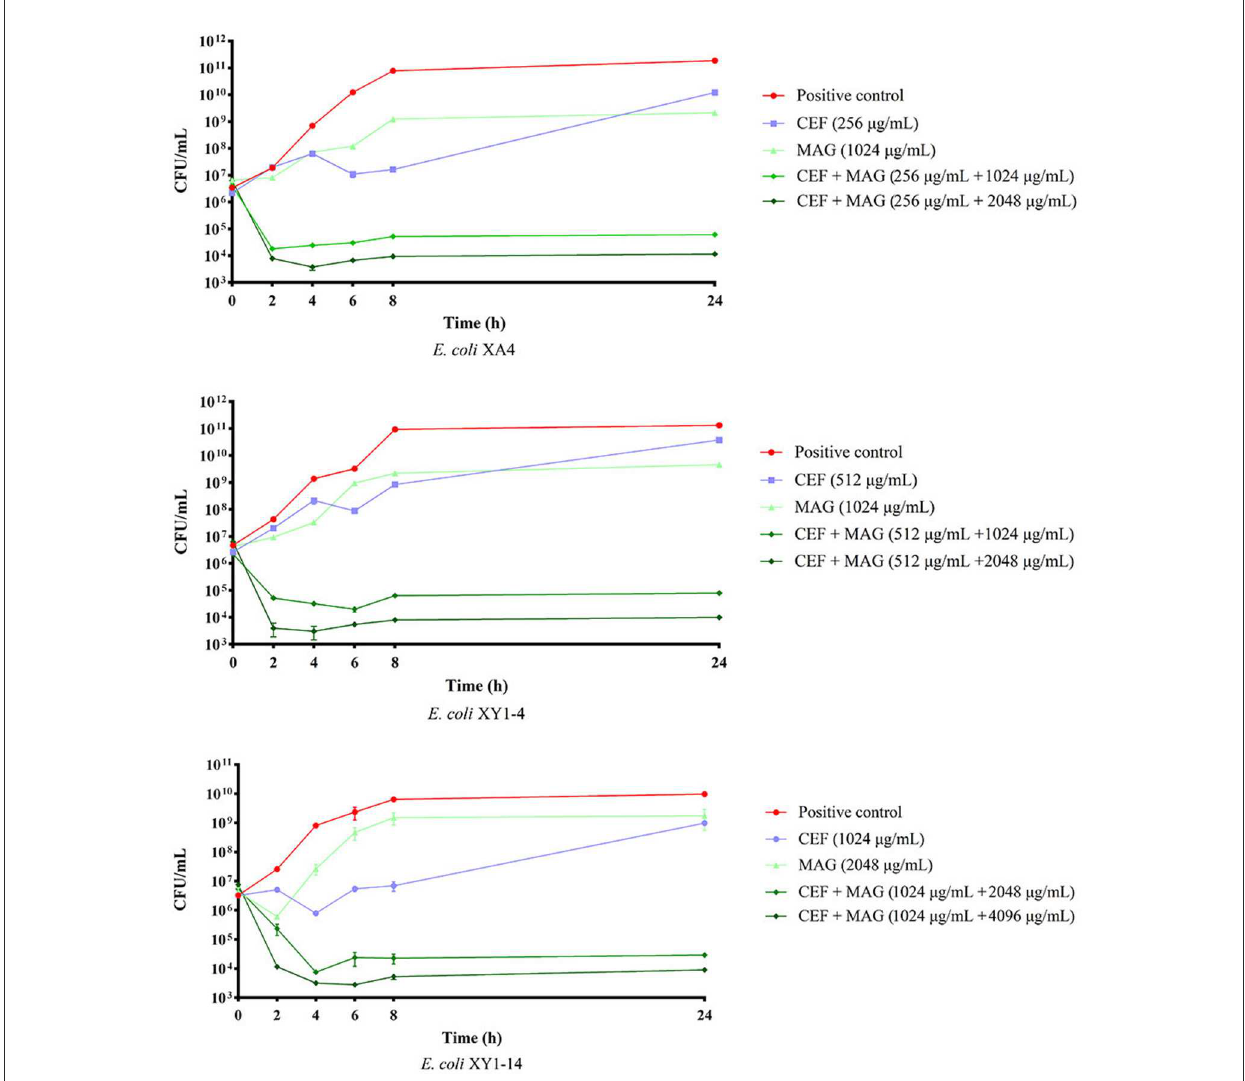
FIGURE4 Bactericidal effect of magnolol (MAG) and cefquinome (CEF) in different combinations or levels against MDR E. coli. All data are expressed as mean ± SD determined from three independent experiments performed in triplicate.